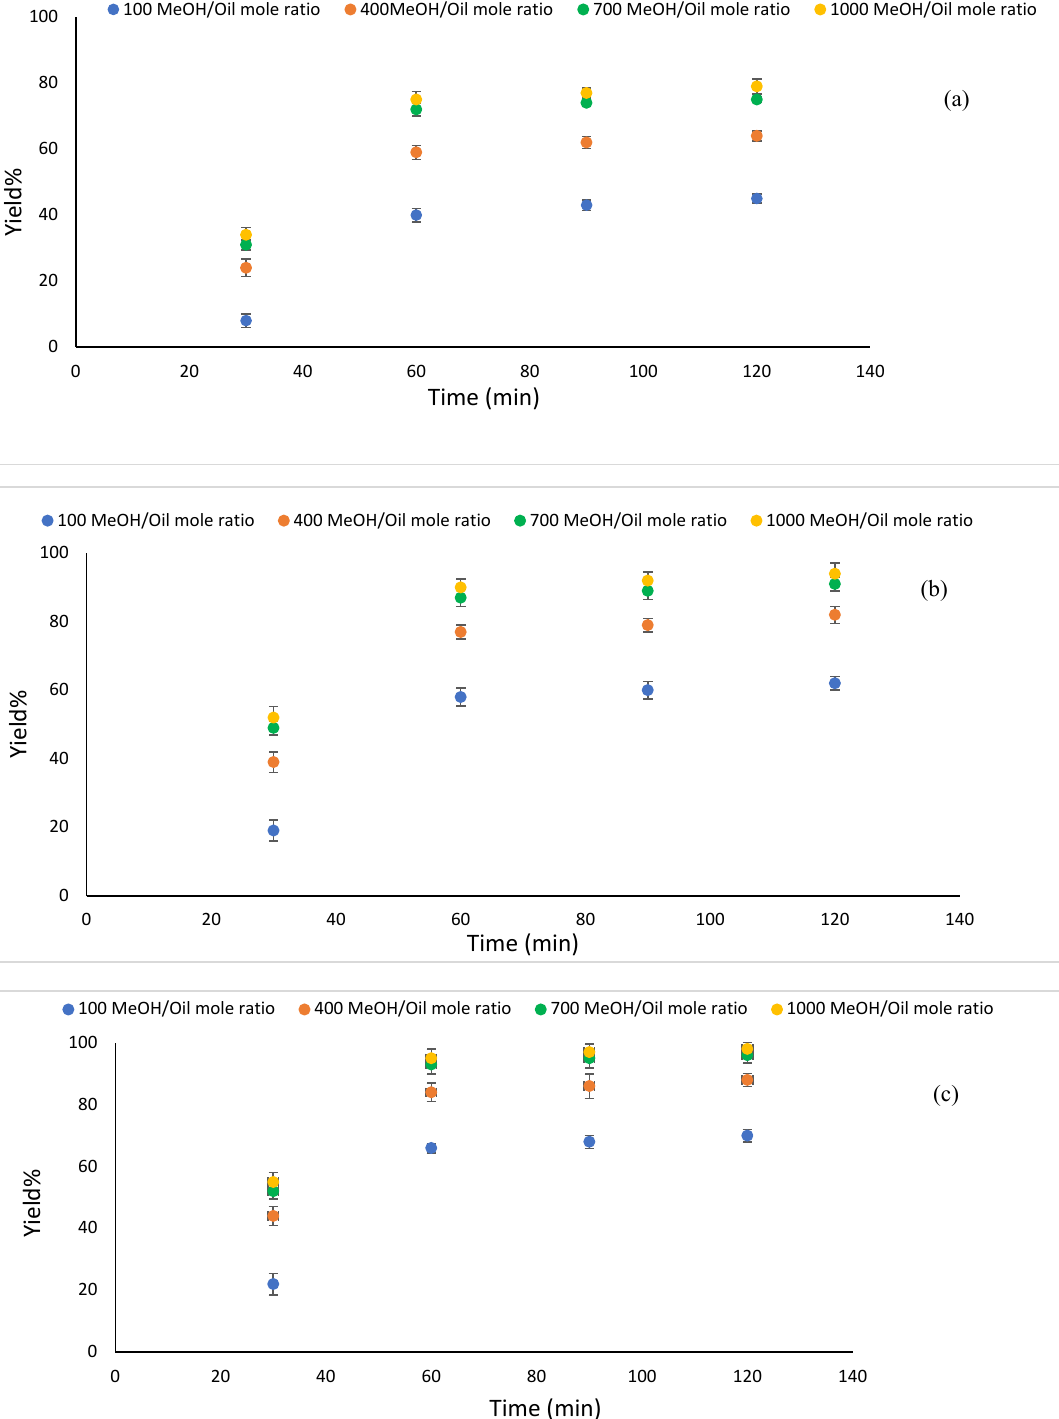
Figure 4. Effect of reaction time on the FAME yield at reaction temperature of ( a ) 30 °C ( b ) 50 °C and ( c ) 70 °C.